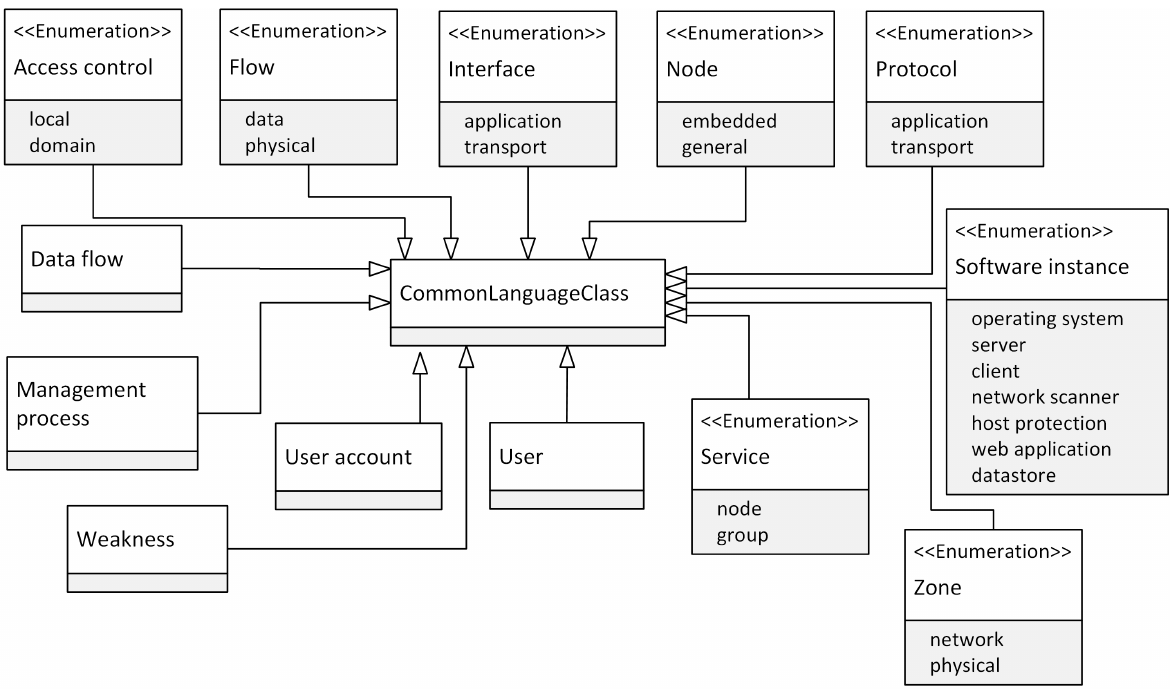
Figure 7. Common language of the three chosen metamodels for the study of the SCADA